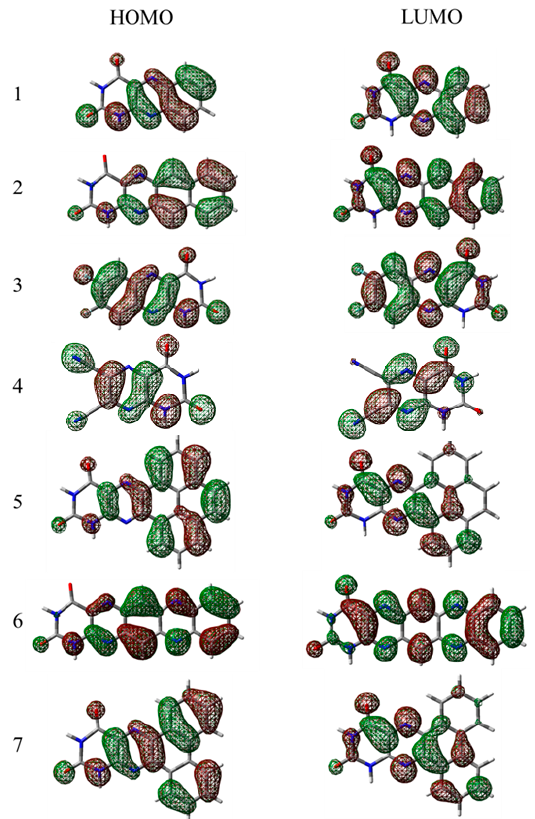
Figure 4. DFT calculated HOMO and LUMO orbitals of the fused alloxazine form compounds.